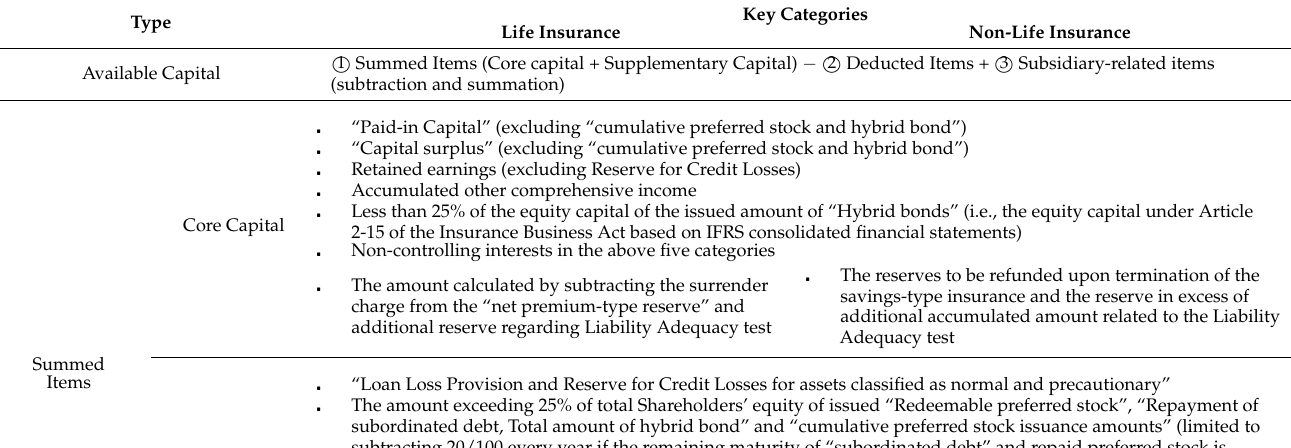
Table A1. Details of RBC ratio calculation components.